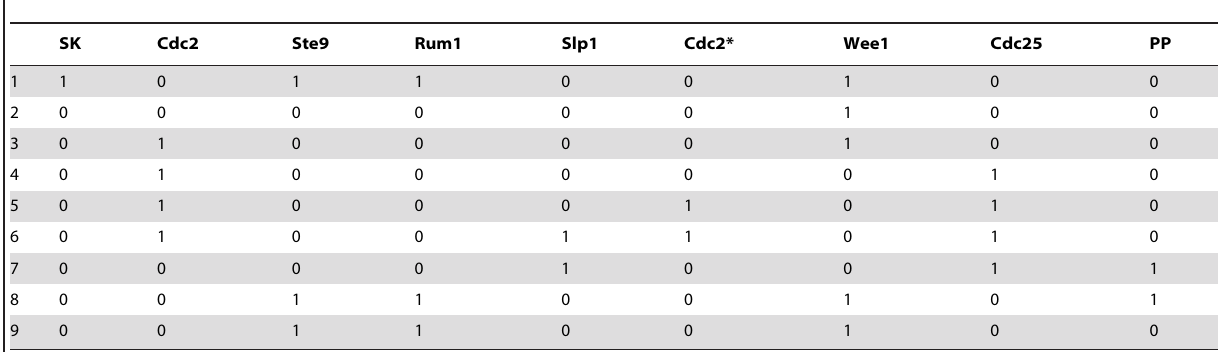
Table 2. The biological pathway of fission yeast cell